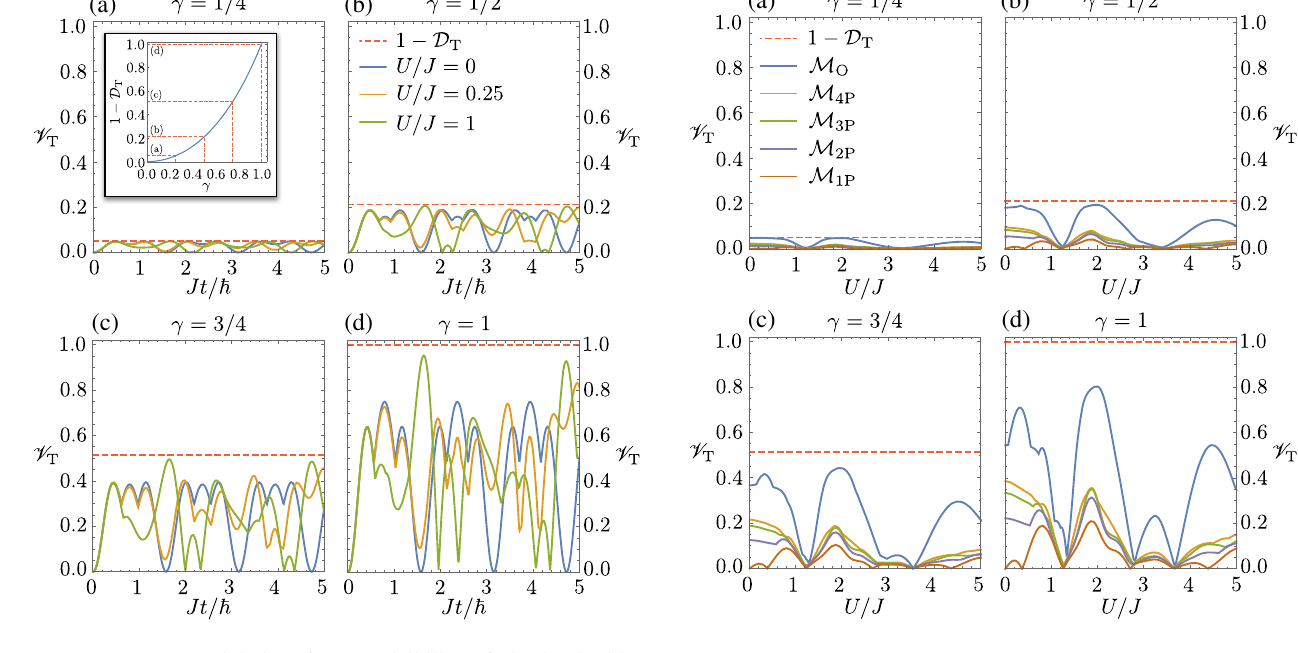
Figs. 7(a) – 7(d), the upper bound from Eq. (65) limits the